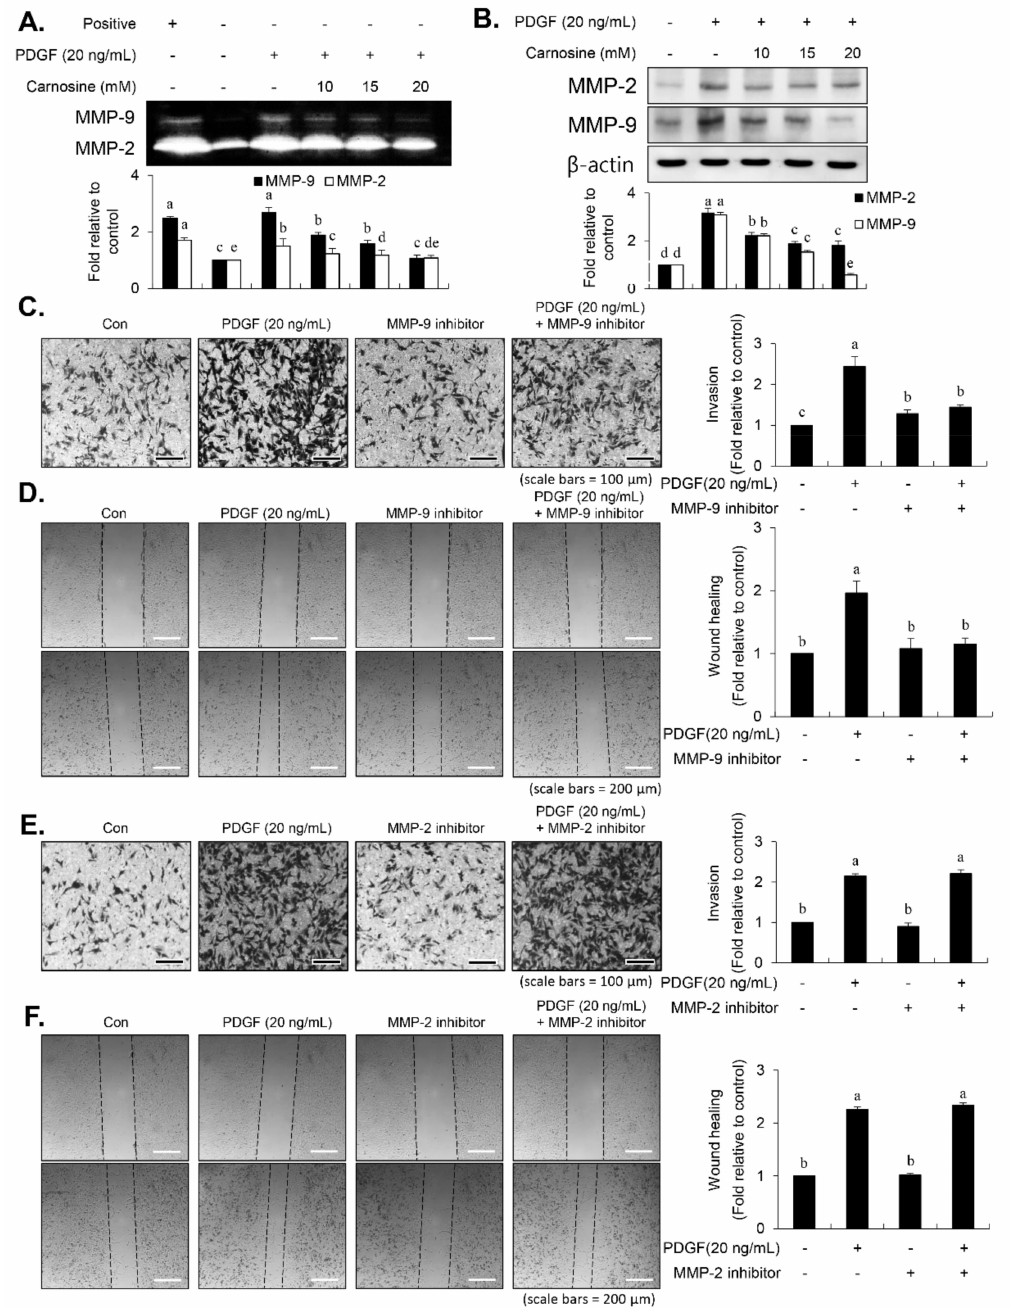
Figure 8. Carnosine suppressed PDGF-induced migration of VSMCs via reducing the matrix metalloproteinase (MMP)-9 activity. Serum-starved VSMCs were pre-incubated with carnosine (10, 15, and 20 mM) for 45 min, followed by reaction with PDGF (20 ng / mL) for 24 h. ( A ) Conditioned medium was evaluated for the gelatinase activities of MMP-2 and MMP-9 via gelatin zymography. The culture medium containing 10% FBS was used as positive control (Positive). ( B ) Cell lysates were employed for the immunoblot analysis. ( C – F ) Serum-starved VSMCs were pre-incubated with either MMP-2 inhibitor (10 nM) or MMP-9 inhibitor (10 nM) for 45 min, followed by PDGF treatment (20 ng / mL) for 24 h. Then, transwell plate invasion ( C , E ) and wound-healing assay ( D , F ) was performed. All data are expressed as the mean ± SE values of three experiments. The di ff erent letters indicate significant di ff erences between the groups ( p <